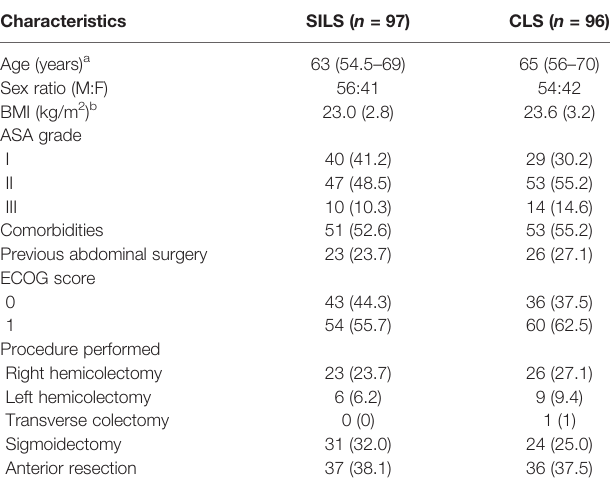
TABLE 2 | Baseline characteristics. TABLE 3 | Intraoperative and postoperative outcomes.